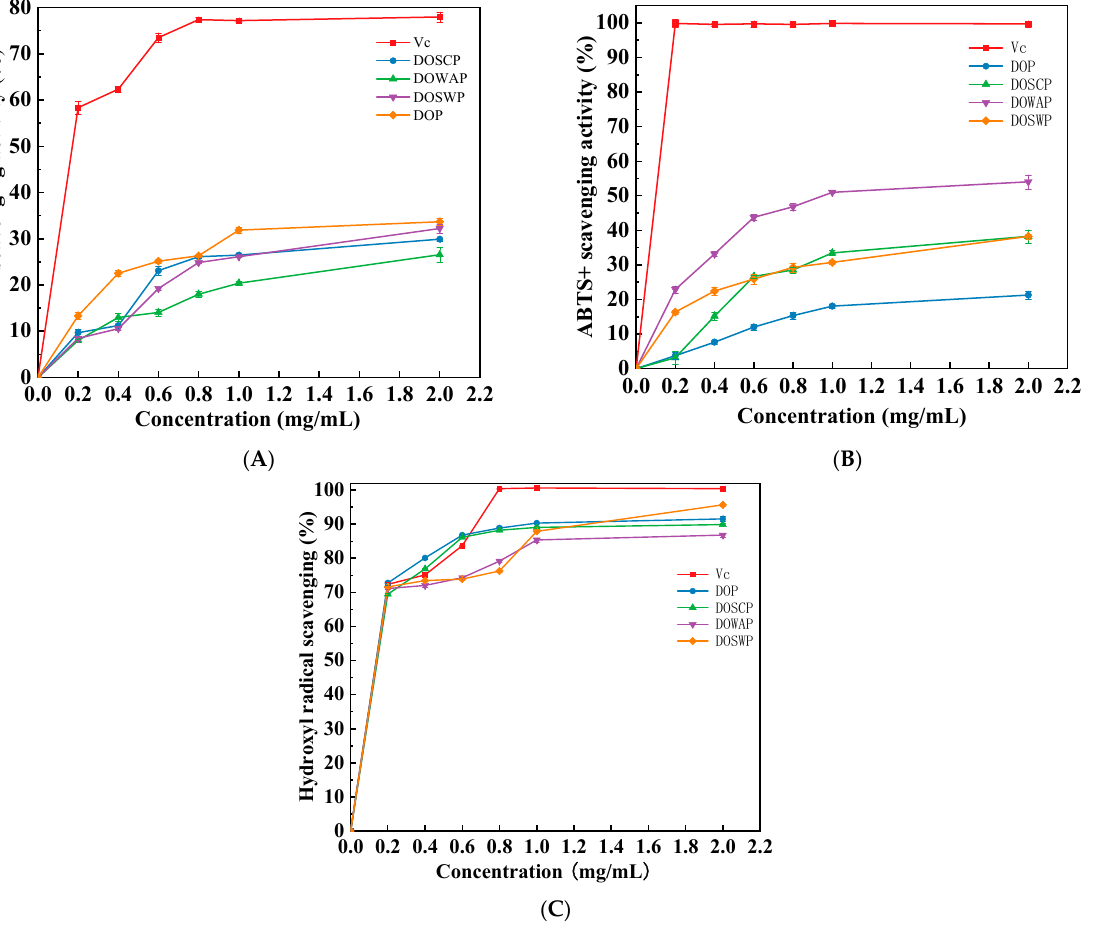
Figure 2. DPPH radical scavenging activity of polysaccharides ( A ); ABTS free radical scavenging activity of polysaccharides ( B ); hydroxyl radical scavenging activity of polysaccharides ( C ). The polysaccharides in each group had strong scavenging ability against ABTS radi- cals (Figure 2B). At the same concentration, the scavenging ability of DOWAP was signif- icantly higher than that of the remaining three groups of polysaccharides, and the scav- enging ability against ABTS radicals of unfermented polysaccharide DOP was the weak- est. The scavenging activity of each group of polysaccharides against ABTS radicals in- creased significantly in the range of 0.2~1.0 mg/mL, and the growth trend of the